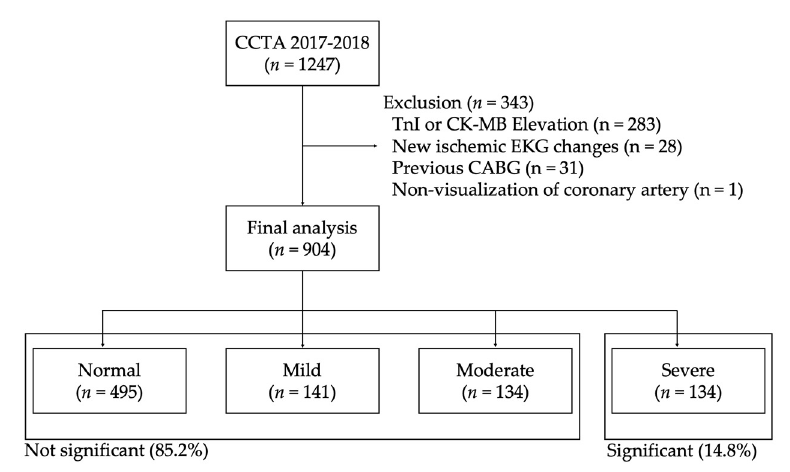
Figure 1. Study Figure 1. Study flowchart.